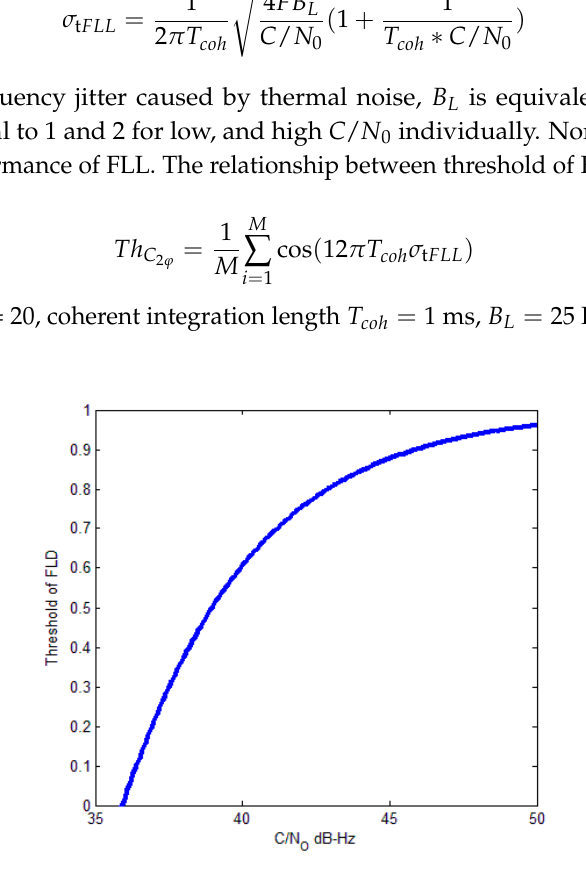
Figure 13. Relation between threshold of FLD and C / N 0 ( M = 20).